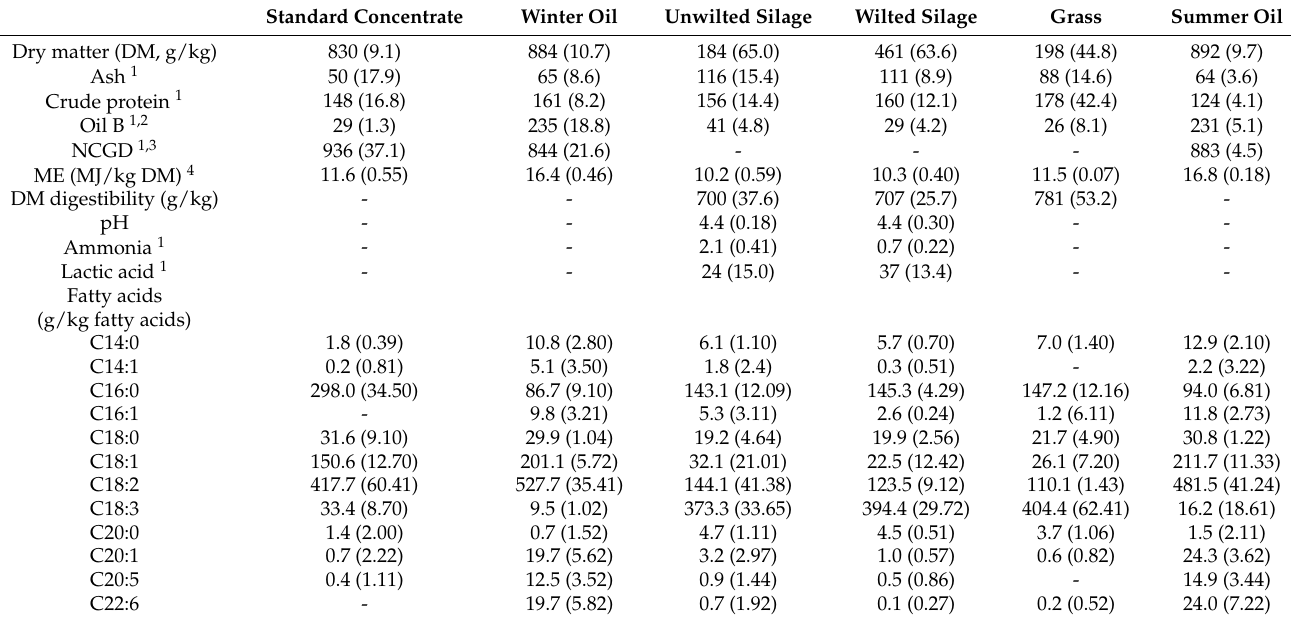
Table 1. Chemical composition (mean (standard deviation)) and estimated metabolisable energy concentration of the forages and